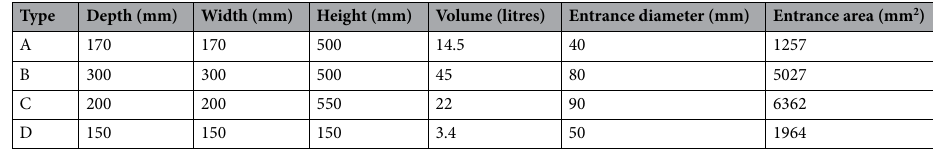
Table 1. Attributes of the four different types of nest box analysed in the main analysis (dimensions in mm). All boxes were constructed of timber, with circular entry holes in the upper half, and attached to trees at